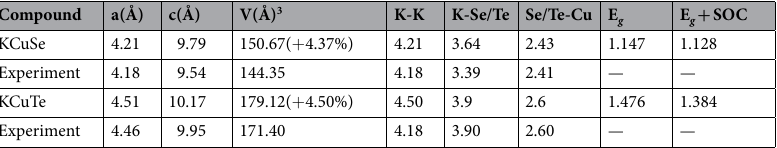
Table 1. Optimized lattice parameters, volume and percentage error w.r.t experimental data 5 of ternary in eV.